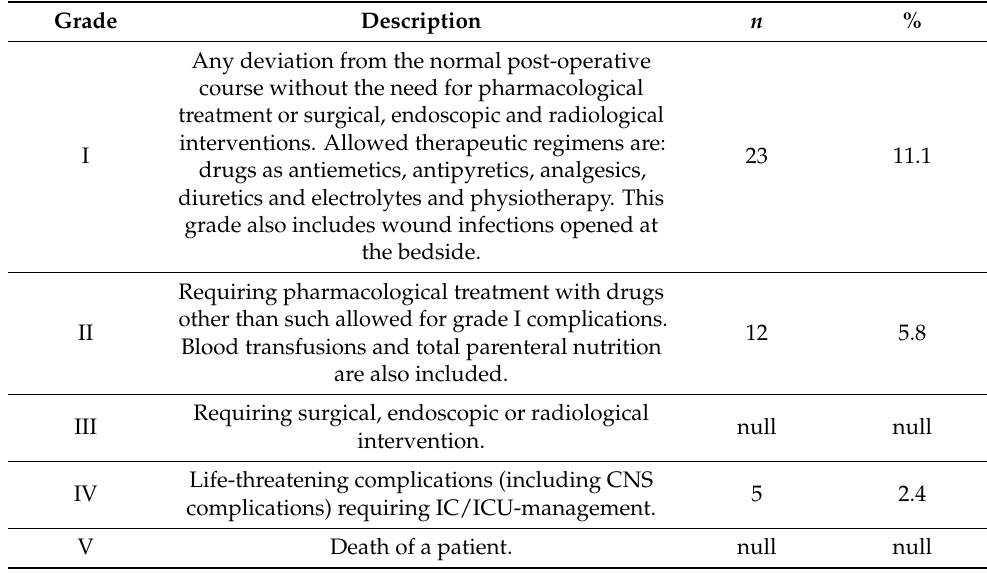
Table 3. Results and description of surgical complications according to Clavien-Dindo classification.